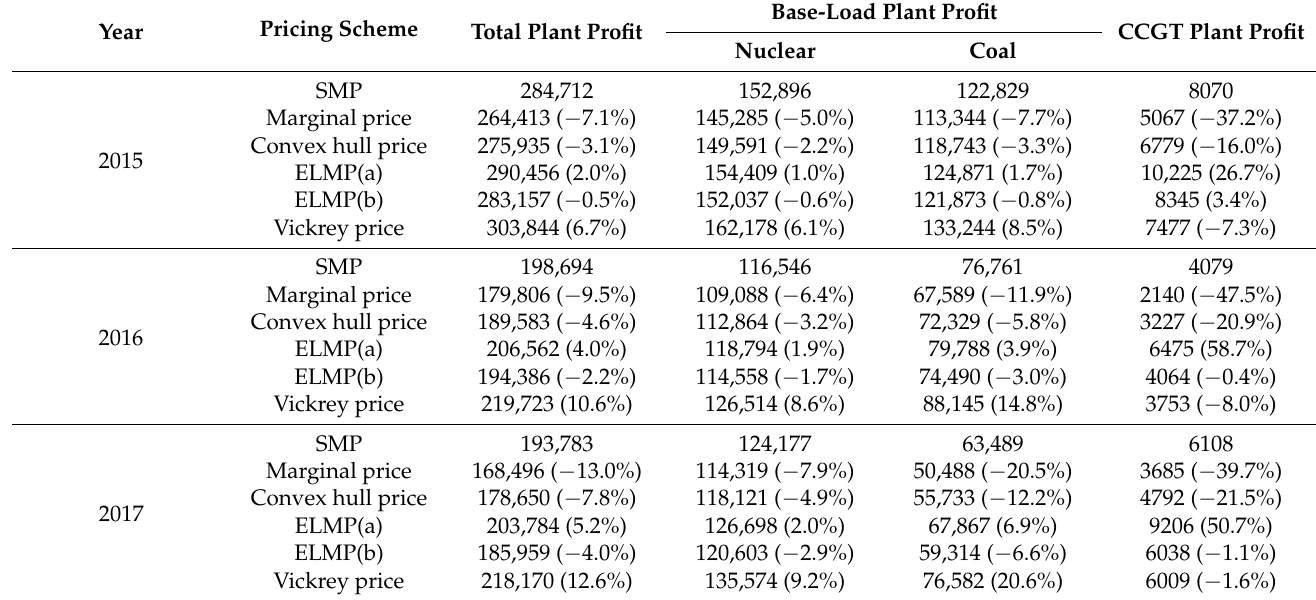
Table 5. Comparison of profits by market price (hundred million